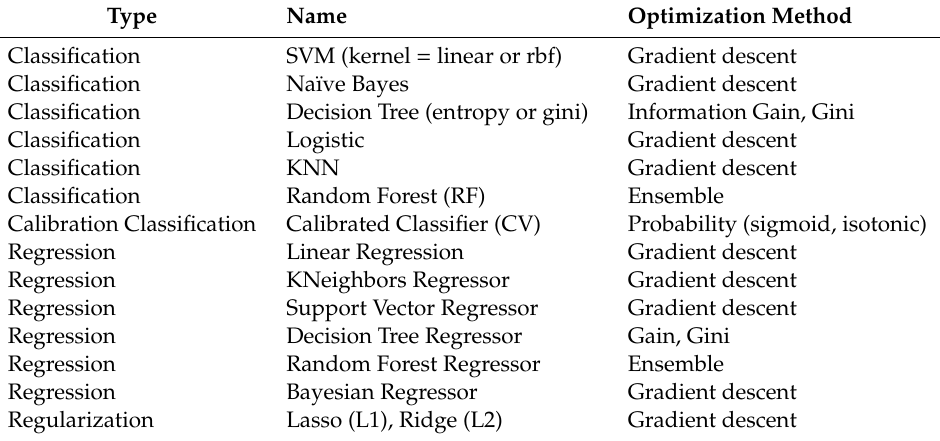
Table 9. Statistical analysis methods on the selected datasets